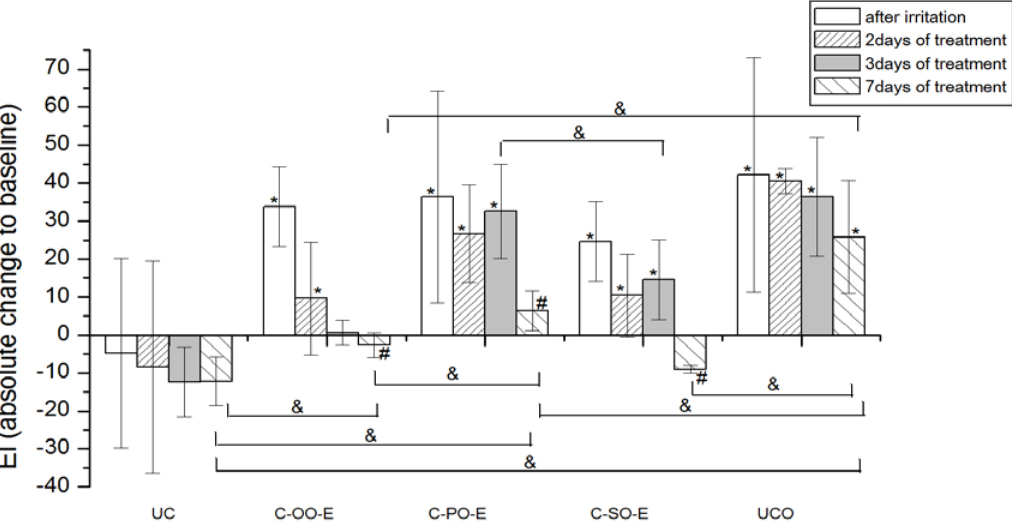
Figure 5. The influence of the irritation per se and samples C-OO-E, C-PO-E and C-SO-E after irritation on EI. Parameters were expressed as absolute changes to baseline at distinct time points. The effects of different formulations were compared mutually and to UC and UCO (significant differences being marked with &). Differences to corresponding sample without SJW (C-OO, C-PO and C-SO) were checked only on day 7, significant differences being marked with (#). (*) is for significant difference of EI at distinct time point related to corresponding baseline (means were